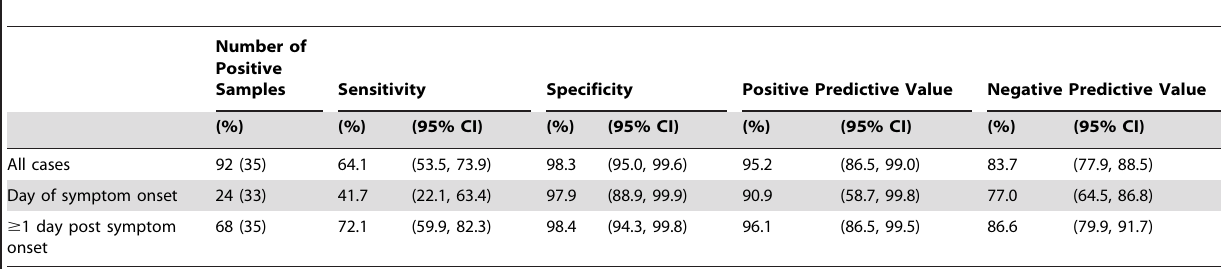
Table 1. Performance of the QuickVue Influenza A + B Rapid Test for Influenza A H1N1pdm, Managua, Nicaragua,